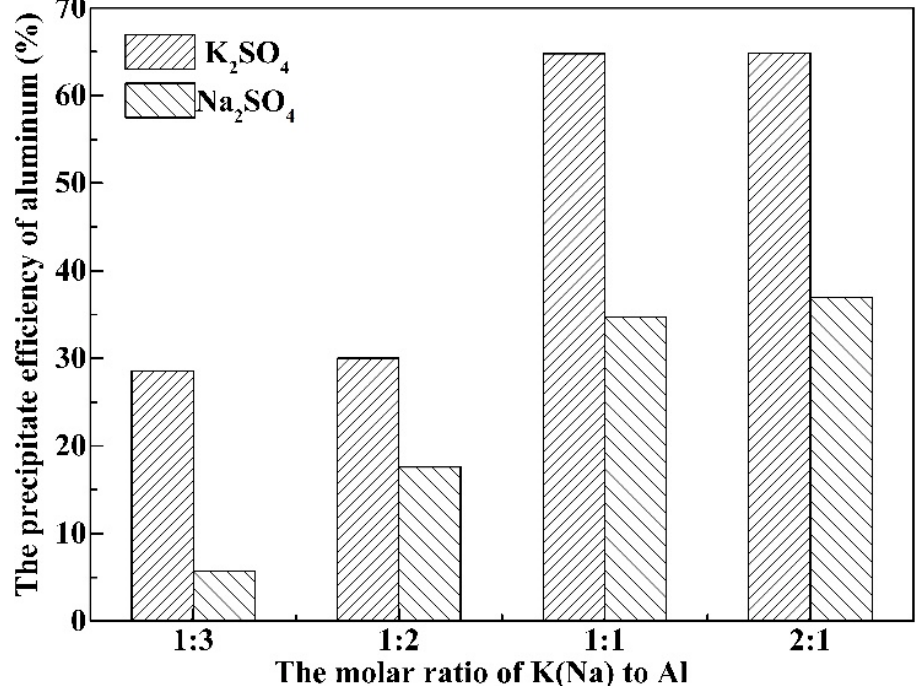
Figure 3. Effect of the K(Na)/Al molar ratio on the precipitation efficiency of aluminum.